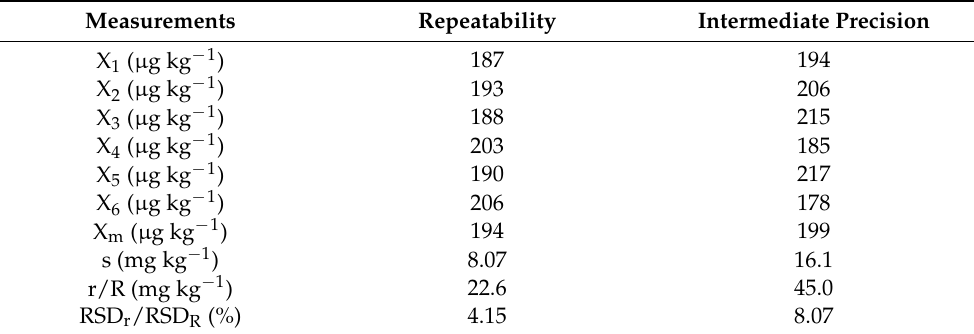
Table 3. Results obtained in the repeatability/intermediate precision assays the Au analysis from biological tissues by GFAAS ( n = 6 parallel